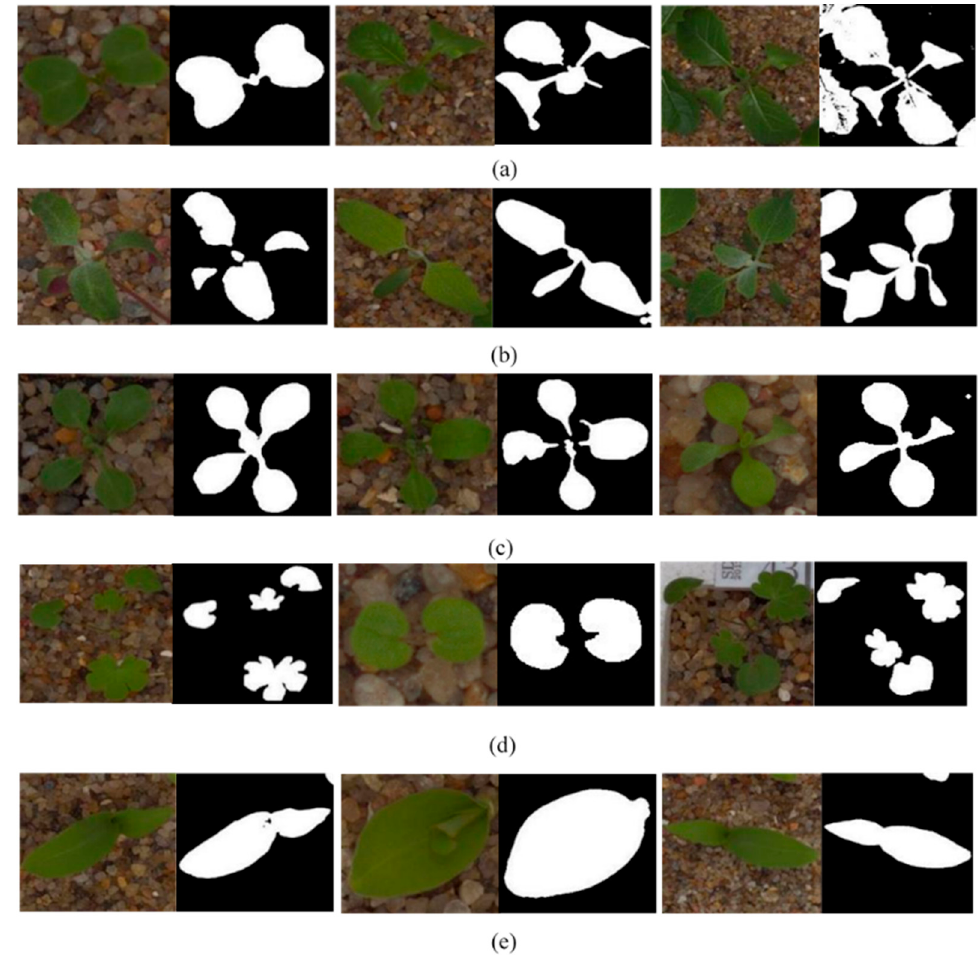
Figure 1. Sample images of ( a ) Charlock, ( b ) Fat Hen, ( c ) Shepherd’s purse, ( d ) Small-flowered Cranesbill, and ( e ) Maize.